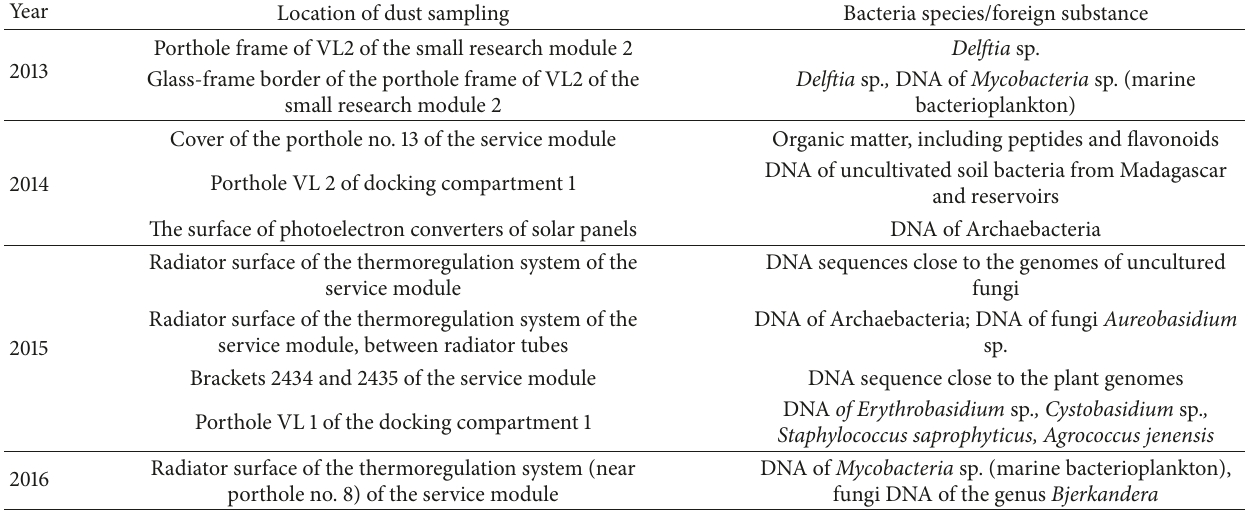
Table 2: Presence of different bacterial DNA in the samples of cosmic dust from the surface of ISS.